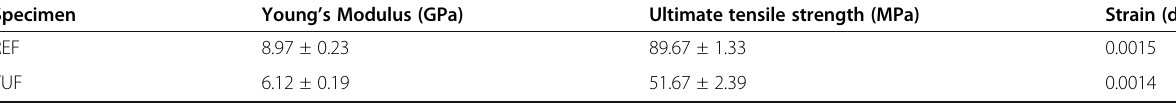
Table 3 Young ’ s modulus and Ultimate tensile strength of REF and TUF green biocomposite Specimen Young ’ s Modulus (GPa)